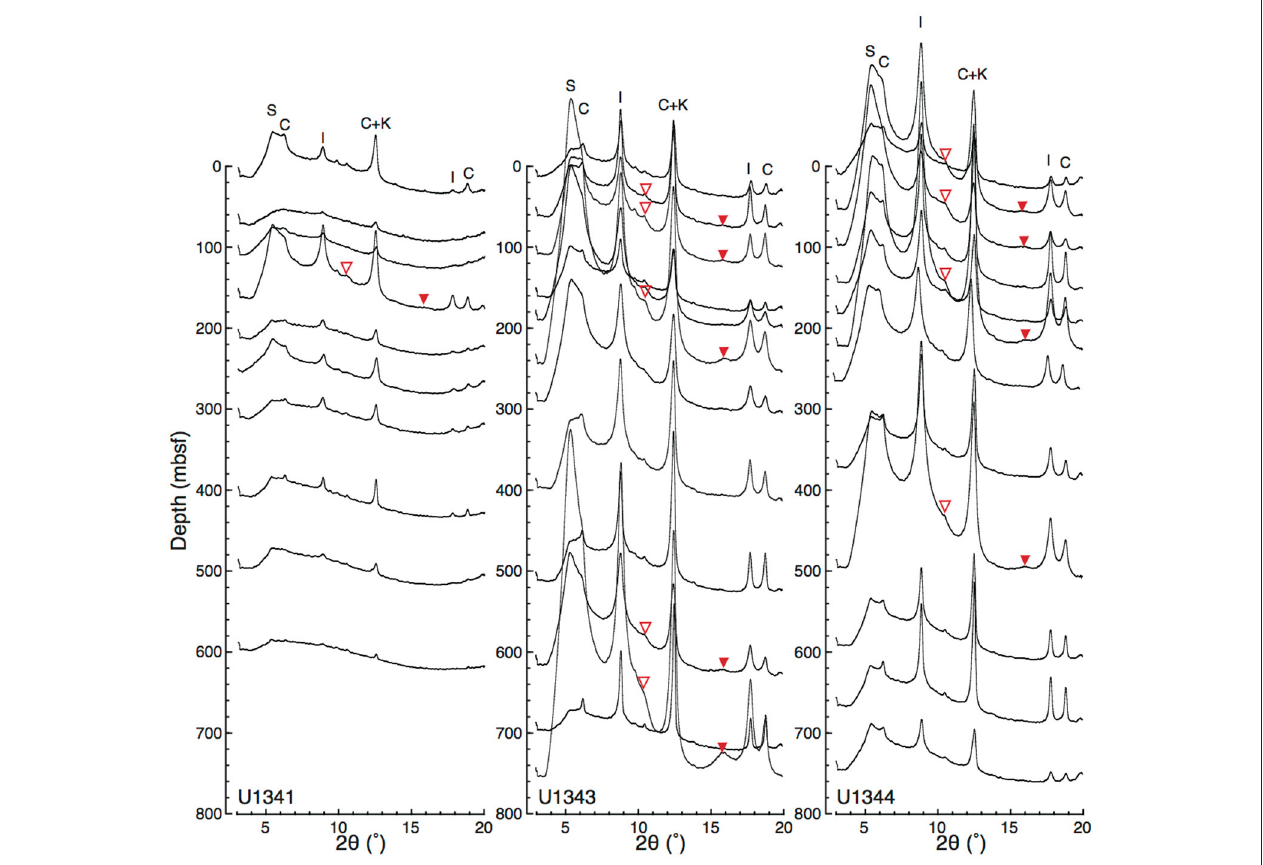
FIGURE 6 | Vertical profiles of X-ray diffractograms from Sites U1341, U1343, and U1344. The base line of each diffractogram at its left edge (2 θ = 3 ◦ ) corresponds to sampling depth. Open and solid triangles indicate the detected composite reflections of illite-(001)/smectite-(002) and illite-(002)/smectite-(003), respectively. The enlarged views of the detected composite reflections are shown in Figures S1,